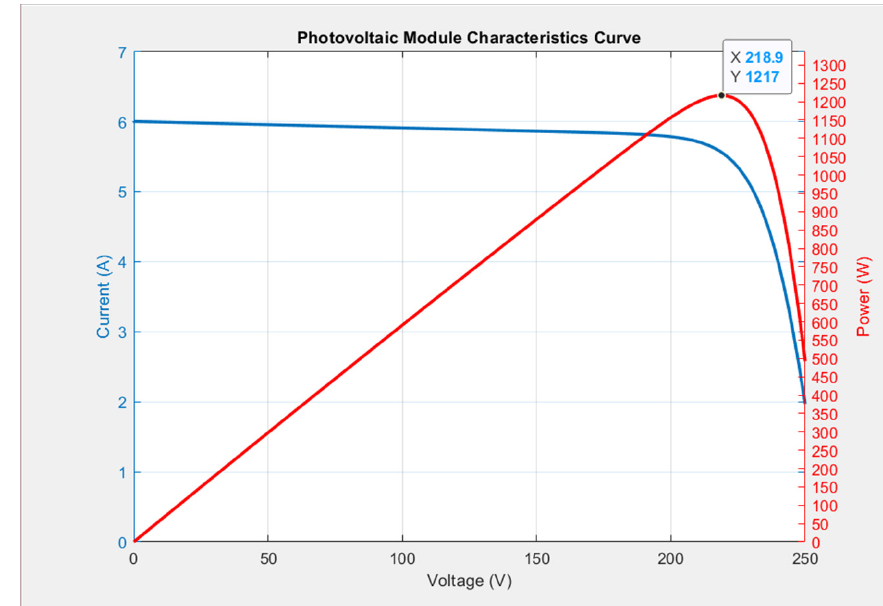
Figure 5. Simulated P–V and I–V characteristic curve for Case 1.